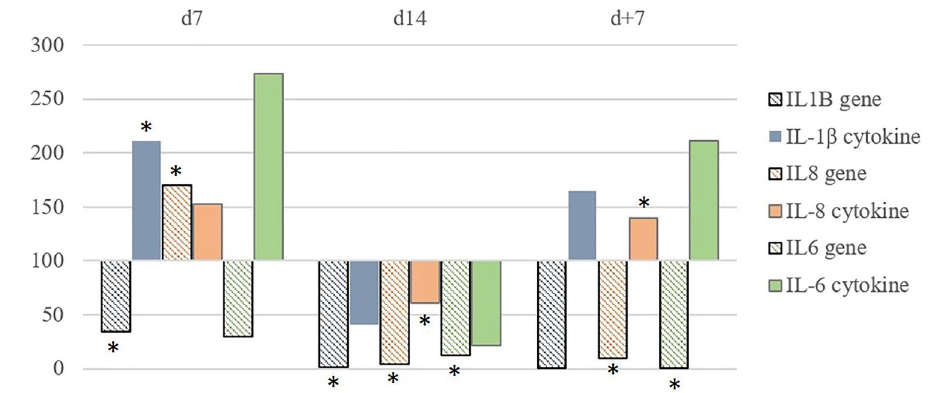
Figure 8. Comparison of cytokine gene and protein expression in test-volunteers during the mission at the indicated timepoints. Gene and protein expression are shown in percent from the values of those in baseline 1 (d-7, taken as 100%). Asterisk (*) indicates p -value ≤ 0.05 in Wilcoxon